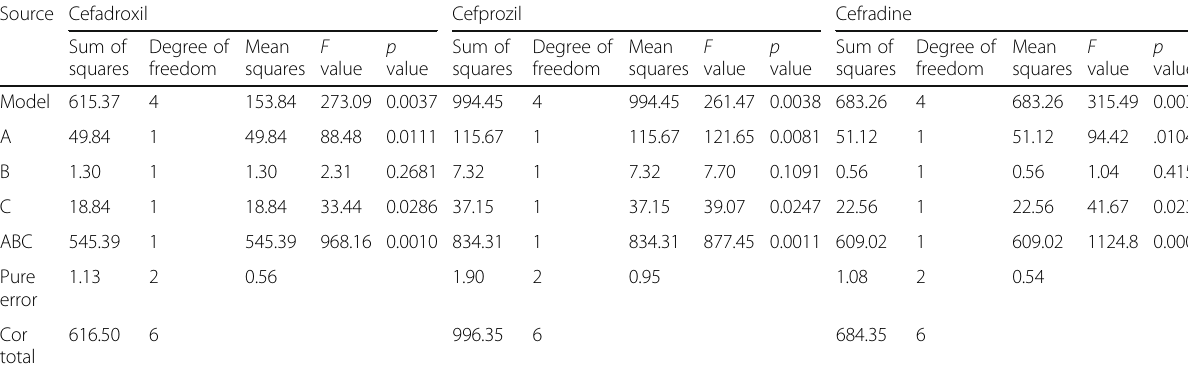
Table 6 ANOVA for the selected factorial model